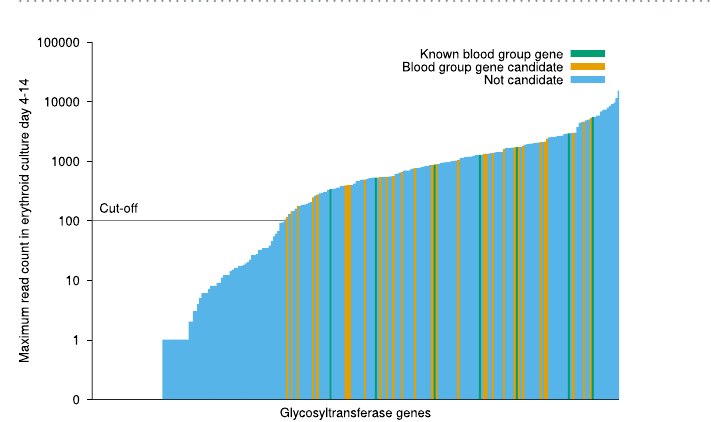
Figure 4. Gene expression for GT genes in erythroid cells. We used RNA-Seq data generated by Shi et al . 32 . to find GTs that are expressed in erythroid cells. Using a cut-off determined by the expression levels of blood group-related GT genes known to be expressed in RBCs ( A4GALT , ABO , ART4 , B3GALNT1 , FUT1 , GBGT1 and GCNT2 ), we found that a majority of GT genes (n = 155) are expressed in RBCs at a level above the cut-off. The genes that remained after filtering for blood group gene candidates and the blood group-related GT genes are indicated in contrasting colours. The cut-off value used is indicated by a horizontal